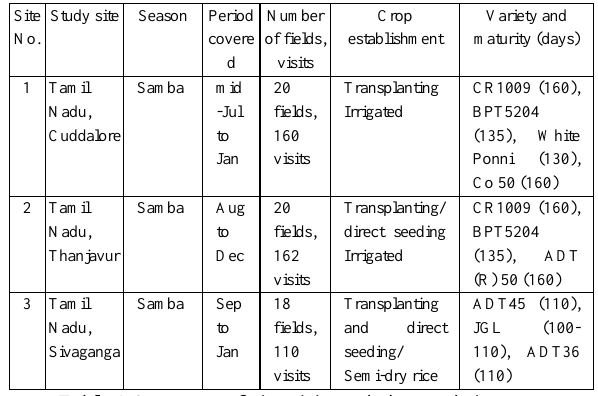
Table 2.Summary of site visits and observed rice crop characteristics during the monitored